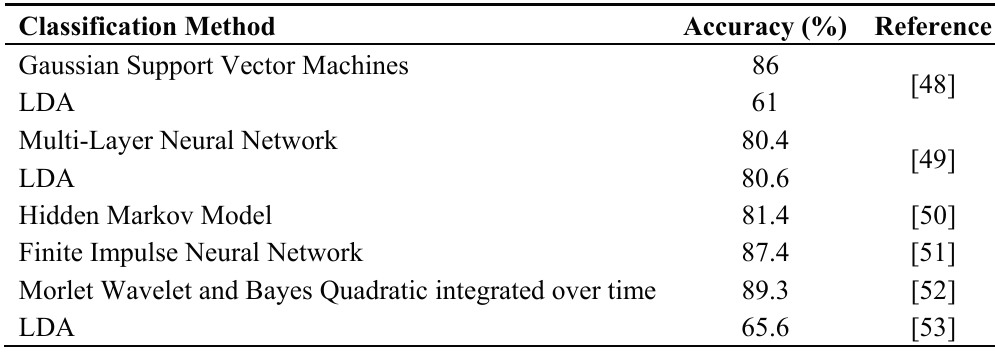
Table 7. Hit rate for other